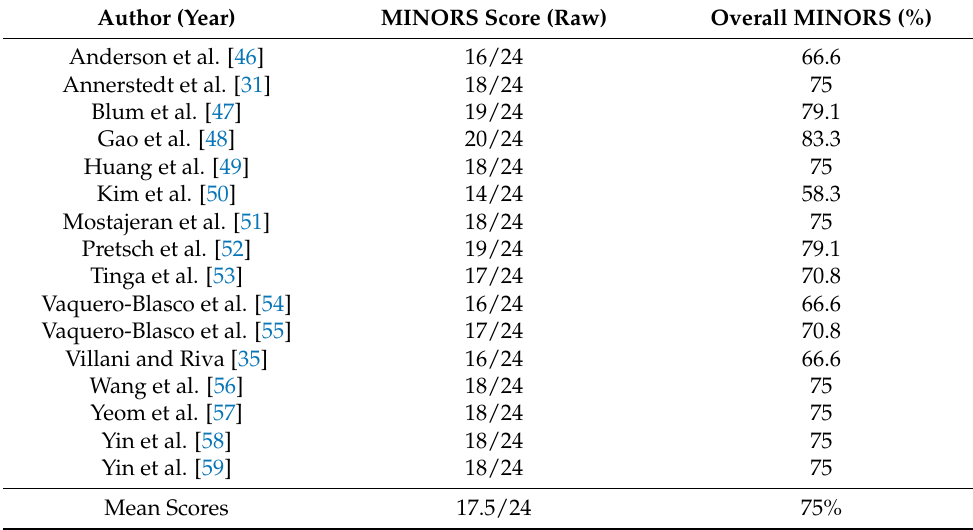
Table 2. Methodological assessment of the study